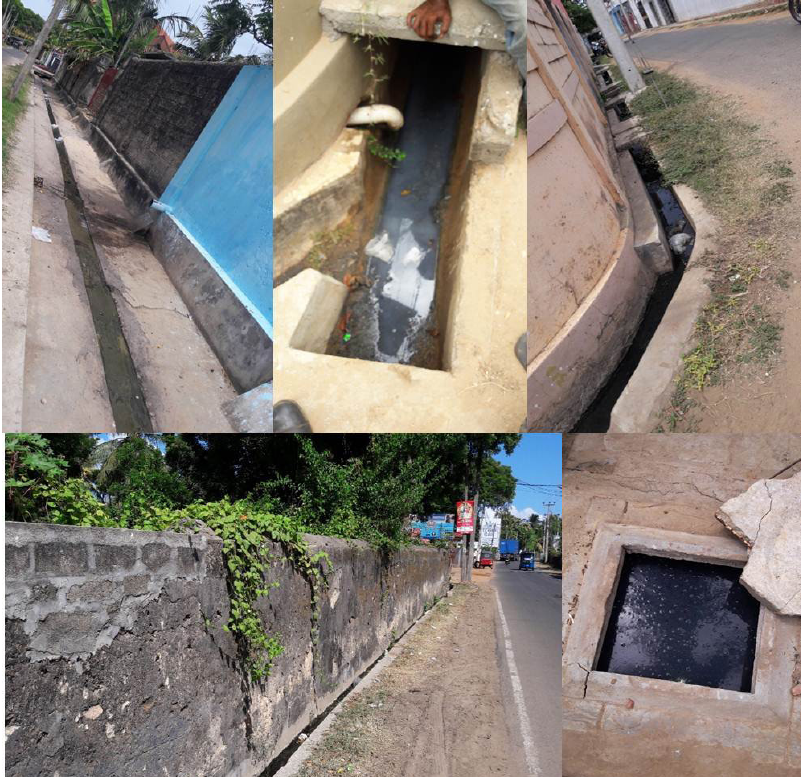
Figure 3: Open surface drain system in Jaffna city that increases ground water pollution and provide sites for preimaginal development of mosquito